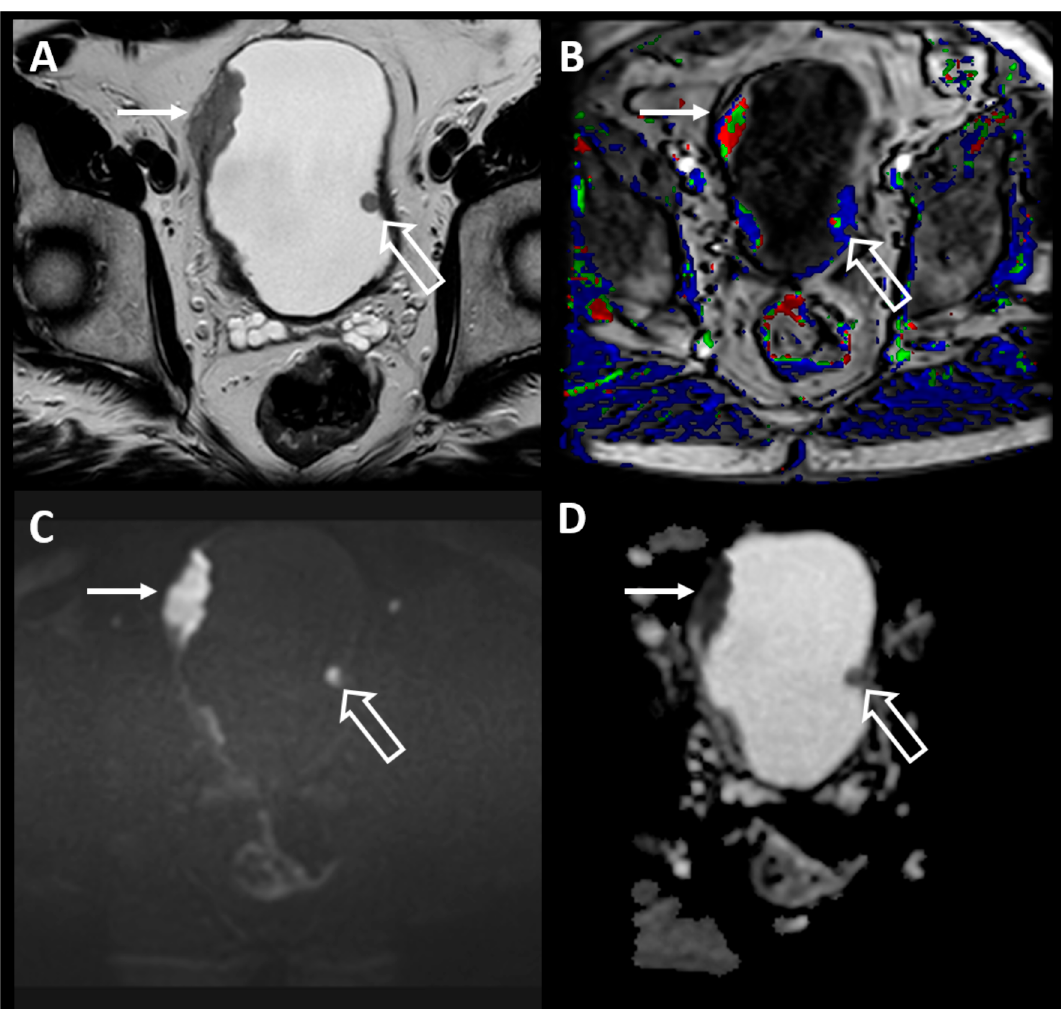
Figure 2. Axial T2-weighted (T2W) ( A ), dynamic-contrast enhanced ( B ), b2000 diffusion-weighted ( C ), and apparent diffusion coefficient ( D ) images of the pelvis in a patient with known multifocal bladder cancer. There are multiple intraluminal masses, one of which (closed arrow) clearly invades through the bladder wall and is consistent with muscle-invasive bladder cancer (MIBC), while the other polypoid mass (open arrow) does not disrupt the T2 hypointense bladder wall, consistent with non-muscle-invasive bladder cancer (NMIBC).